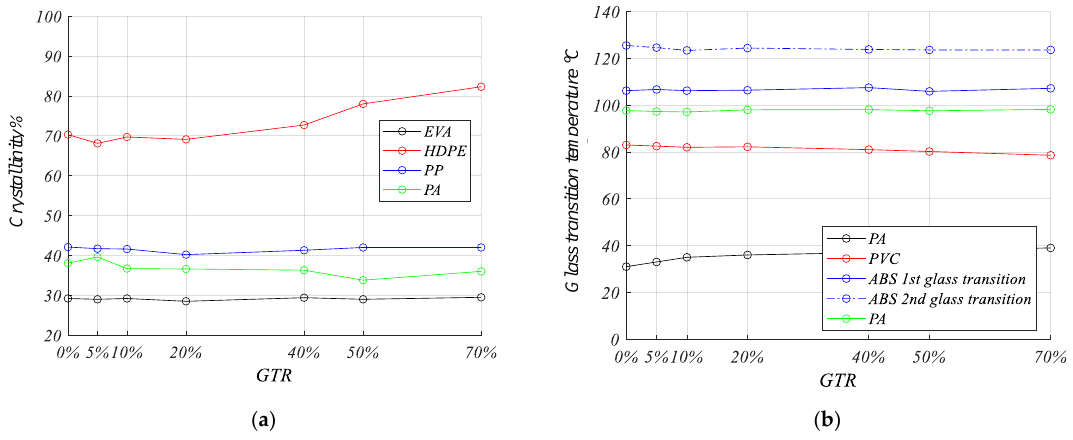
Figure 9. Thermal analysis of end of life tire polymeric blends: ( a ) degree of crystallinity (%) for crystalline polymers and ( b ) glass transition temperature ( ◦ C) for amorphous